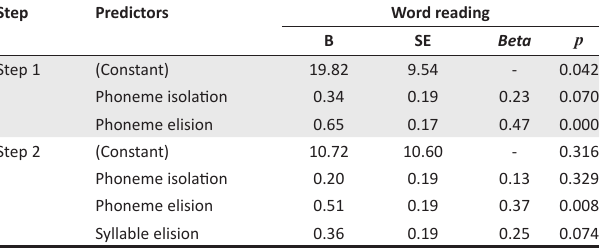
TABLE 3: Summary of multiple regression with word reading as dependent variable and phoneme isolation , phoneme elision and syllable elision as predictors. Step Predictors